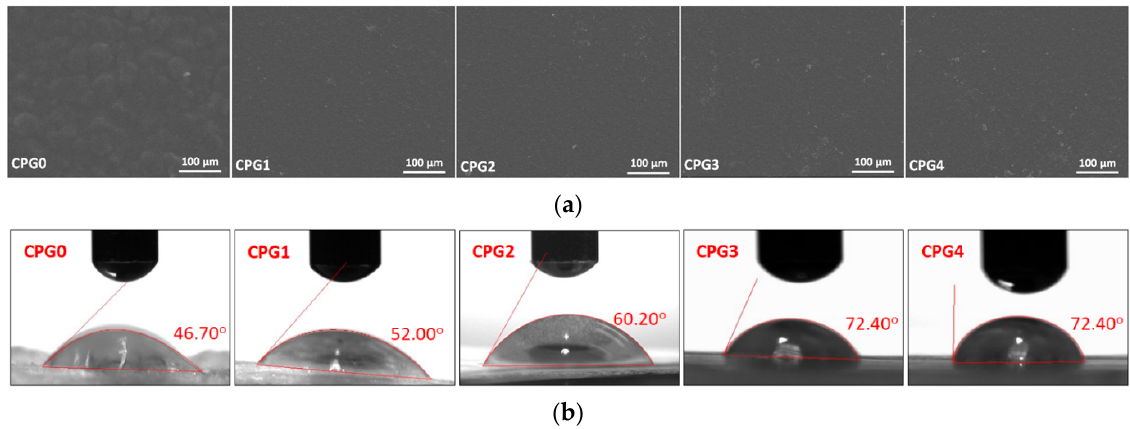
Figure 2 . ( a ) SEM analysis of prepared hydrogels and ( b ) wetting analysis of prepared hydrogels